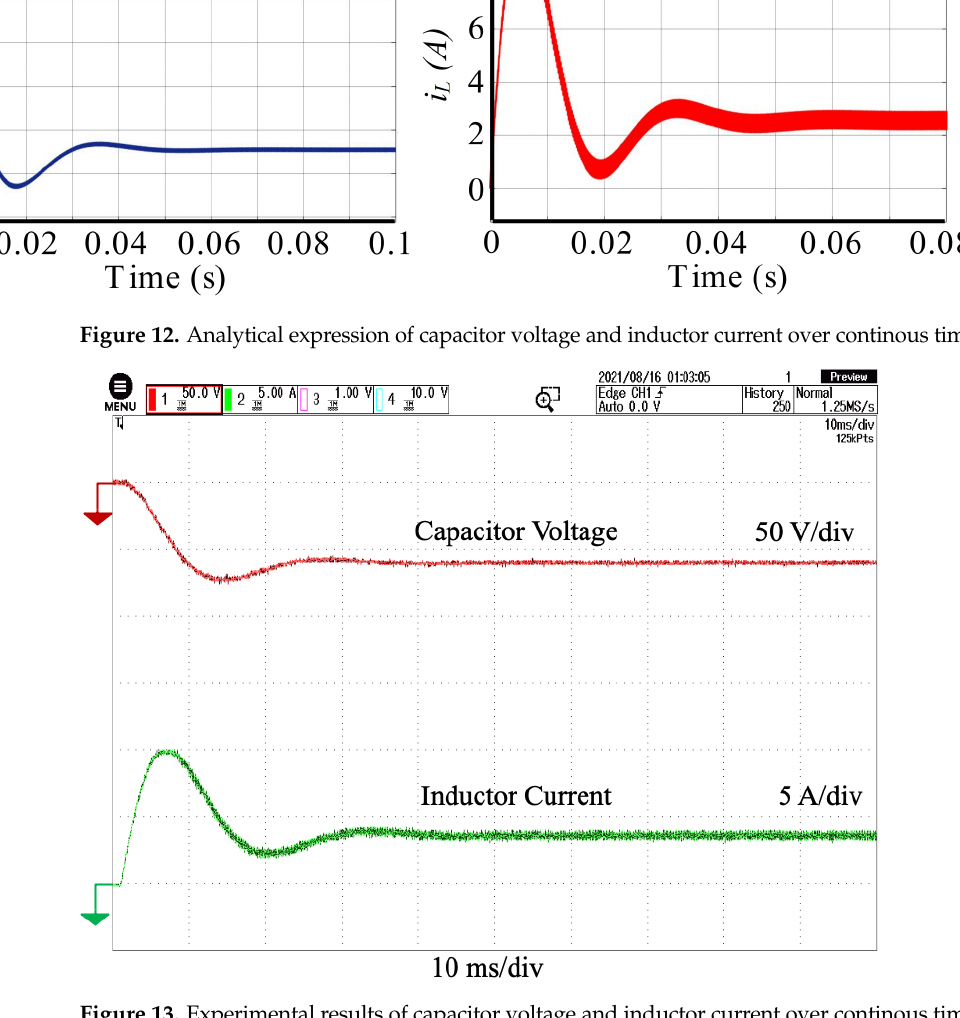
Figure 13. Experimental results of capacitor voltage and inductor current over continous time from S 1